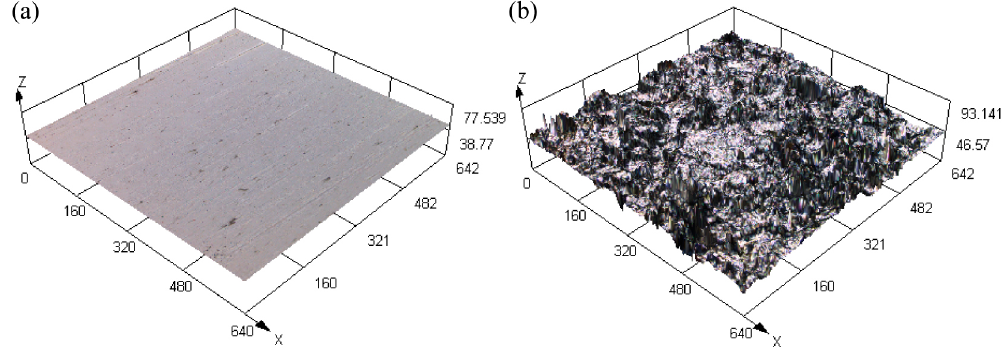
Figure 3. Surface 3D morphology of the substrates subjected to two pretreatment processes: ( a ) polishing and ( b ) sandblasting. Table 3. Surface roughness data of the substrates subjected to two pretreatment processes.